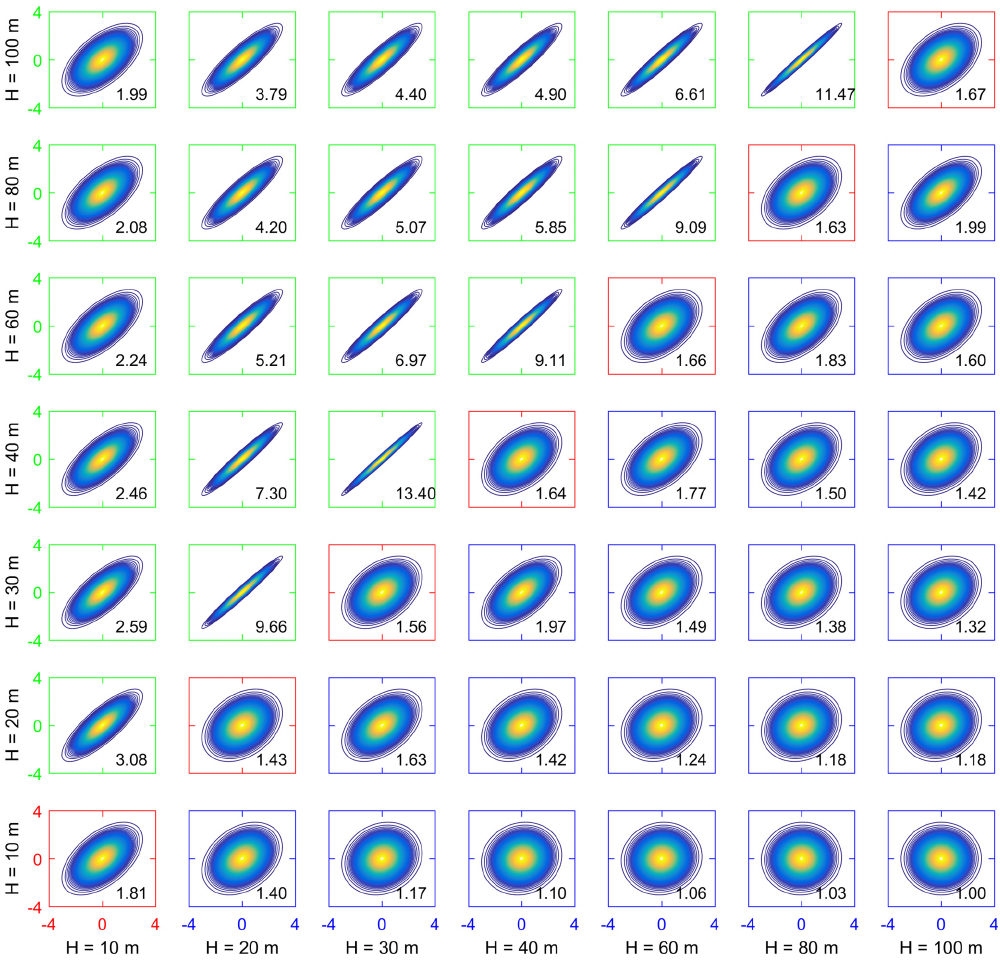
Figure 5. Joint distributions of U gust and L gust at different heights ( H ) from Tower 29. Upper-left off-diagonal panels with green boxes show the joint distributions of U gust at each pair of heights. Diagonal panels with red boxes show the joint distributions of U gust and L gust at the same height. Bottom-right off-diagonal panels with blue boxes show the joint distributions of L gust at each pair of heights. The number at the bottom-right corner of each panel is the average ratio between the major axis and minor axis of ellipses. There are 99 ellipses corresponding to the confidence levels from 1% (the innermost ellipse with the warmest color) to 99% (the outermost ellipse with the coldest